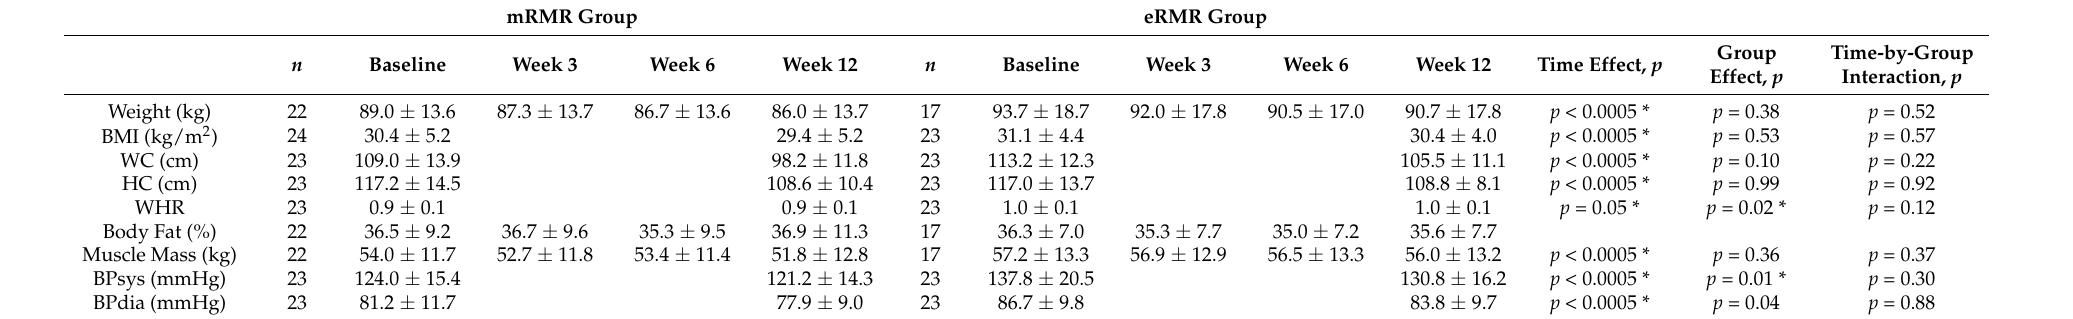
Table 2. Anthropometric and clinical outcomes across the intervention period.